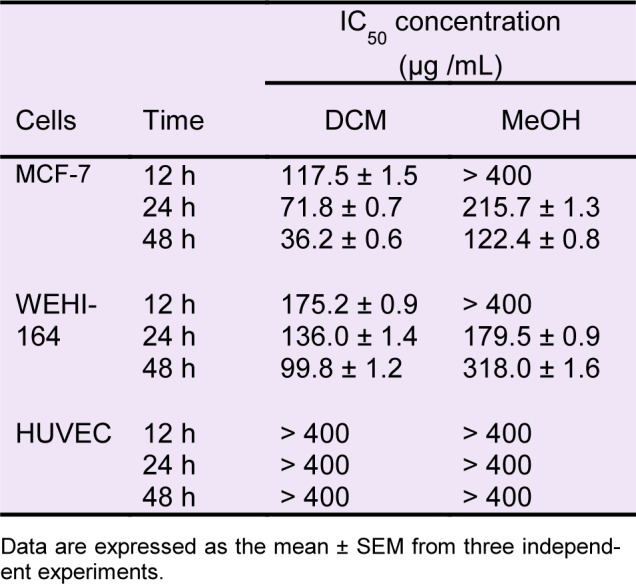
IC50 concentrations (µg/mL) of DCM and MeOH extracts of S. amplexicaulis in MCF-7, WEHI-164, and HUVEC cell lines